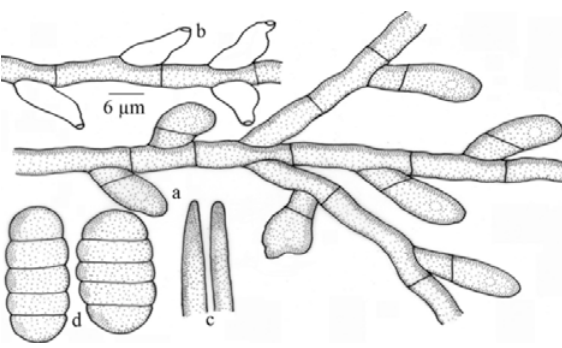
Figure-79. Meliola gymnemae a – Appressorium, b – Phialide, c - Apical portion of mycelial